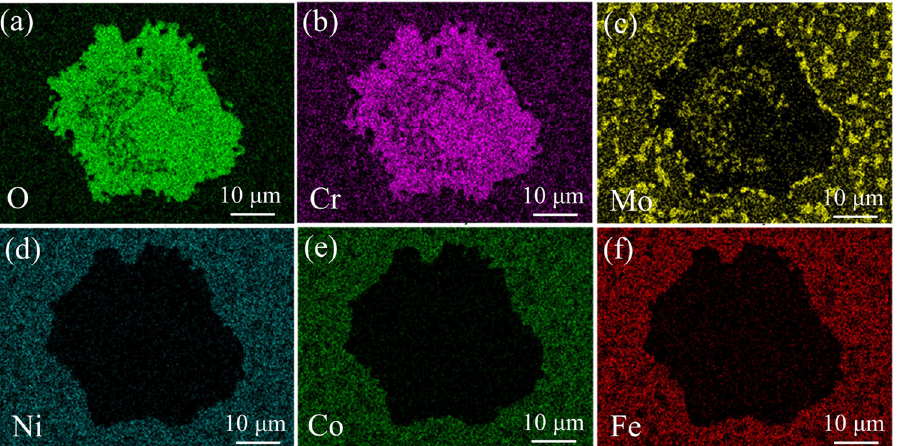
Figure 7: SEM - EDS images of the microstructure in N - HT alloy: ( a ) distribution of O element, ( b ) distribution of Cr element, ( c ) distribution of Mo element, ( d ) distribution of Ni element, ( e ) distribution of Co element, and ( f ) distribution of Fe element.